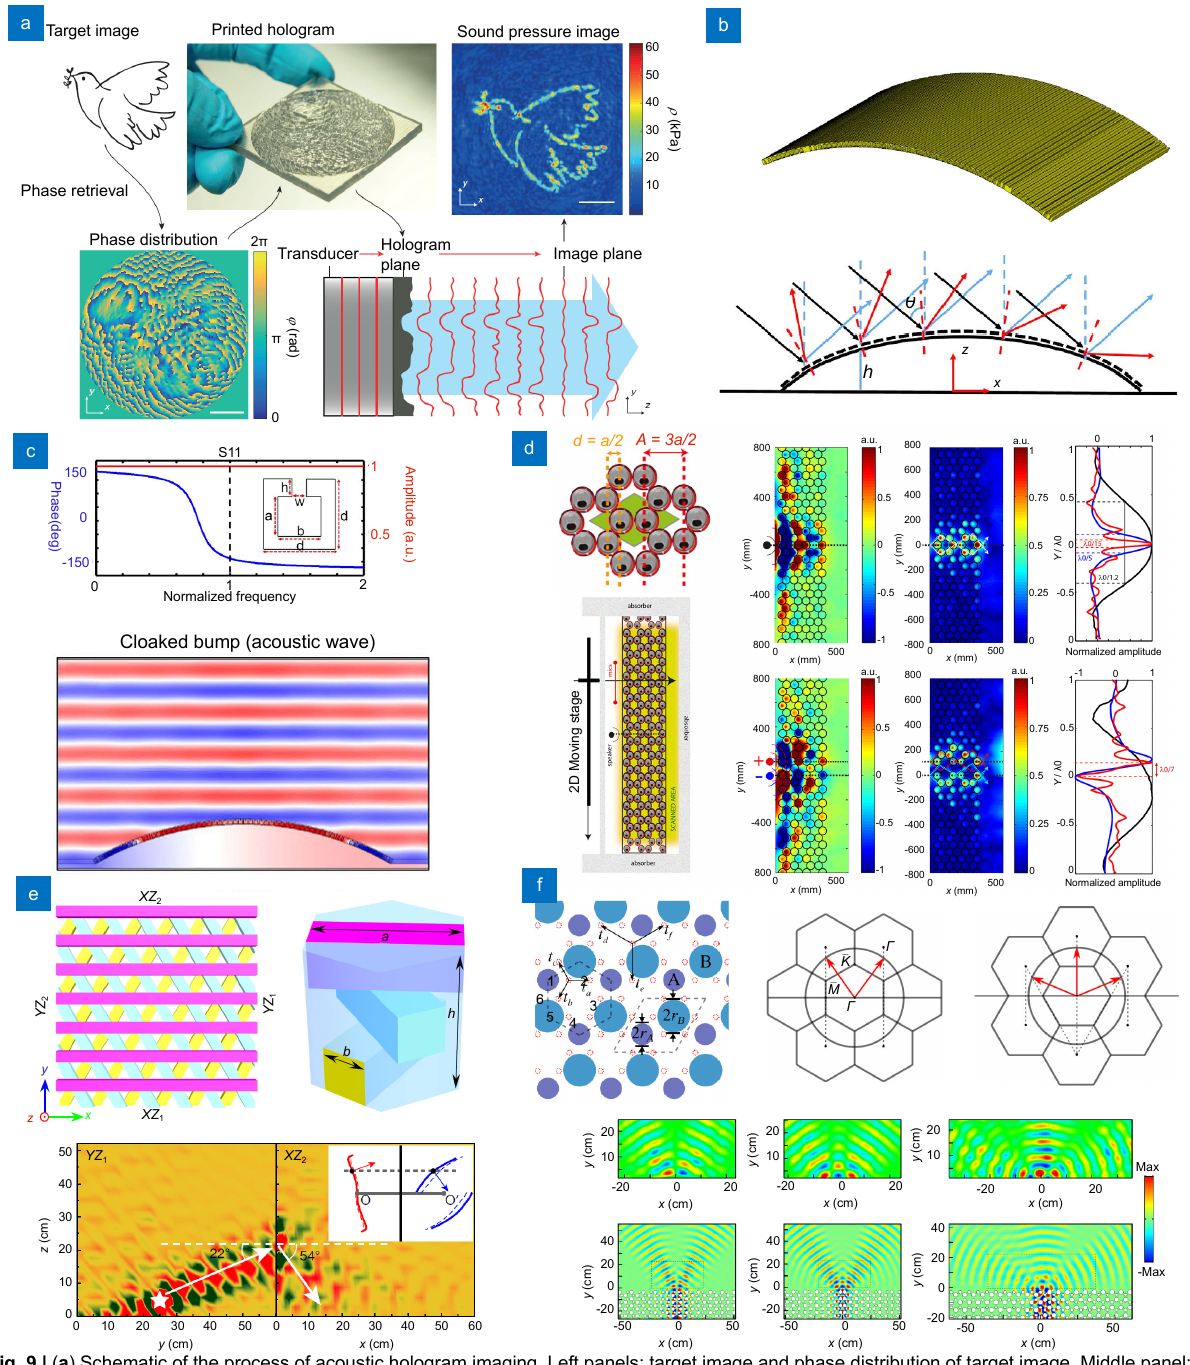
Fig. 9 | ( a ) Schematic of the process of acoustic hologram imaging. Left panels: target image and phase distribution of target image. Middle panel: the metamaterial corresponding to the phase distribution. Right panels: workflow for acoustic metamaterial reconstructing target acoustic images. ( b ) Scheme of a metasurface carpet cloak. The black arrows are the incident waves; the blue arrows and red arrows are the reflected waves with and without metasurface carpet cloak. ( c ) A typical unit cell of the metasurface carpet cloak and its corresponding S11 parameters. ( d ) Left panels: Schematic of the unit cell of flat acoustic superlens and the flat acoustic superlens. Reft panels: experimental demonstration of subwavelength focusing (upper) and imaging (lower) using a flat acoustic superlens. ( e ) Upper panels: schematic of the Weyl phononic crystal and its unit cell. Lower panel: the experimental observation of topological negative refraction. ( f ) Upper panels: schematic of the sonic crystal based on Kekulé lattice (left) and the k-space analysis on the outcoupling of armchair termination at f = 5.6 kHz (middle) and zigzag terminations at f = 5.8 kHz (right). Lower panels: the measurements (upper) and simulations (lower) of three types of topological acoustic antennas corresponding to zigzag domain walls and armchair terminations (left and middle), the armchair domain wall and the zigzag termination (right). Figure reproduced from: (a) ref. 327 , Nature Publishing Group; (b–c) ref. 328 , Nature Publishing Group; (d) ref. 333 , Nature Publishing Group; (e) ref. 335 , Nature Publishing Group; (f) ref. 336 , American Physical